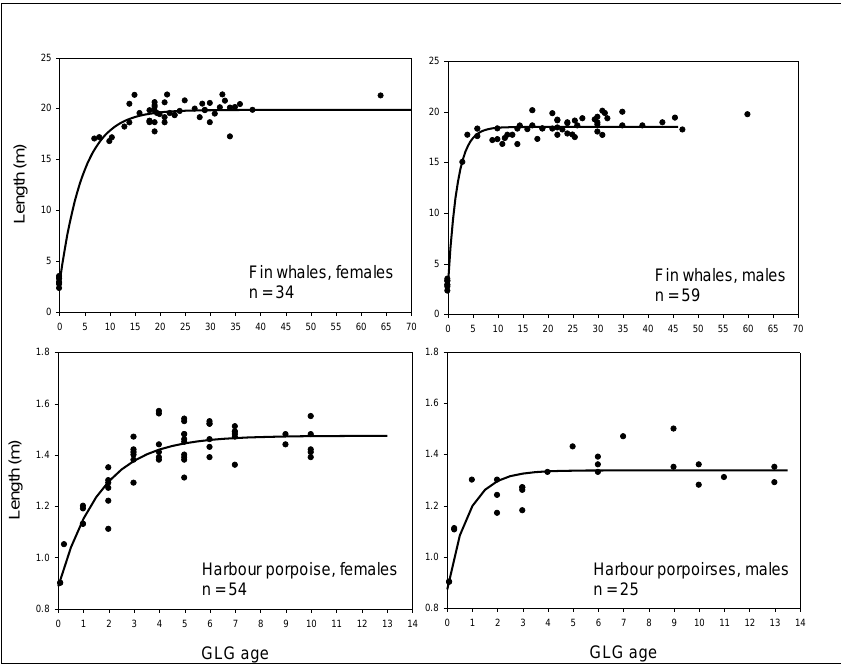
Fig. 4. Growth in female and male fin whales and harbour porpoises for GLG age. No data on sex for the GLG aged Antarctic minke whales were available thus no data on the asymptotic growth within this group are presented. The line is mean asymptotic growth in length